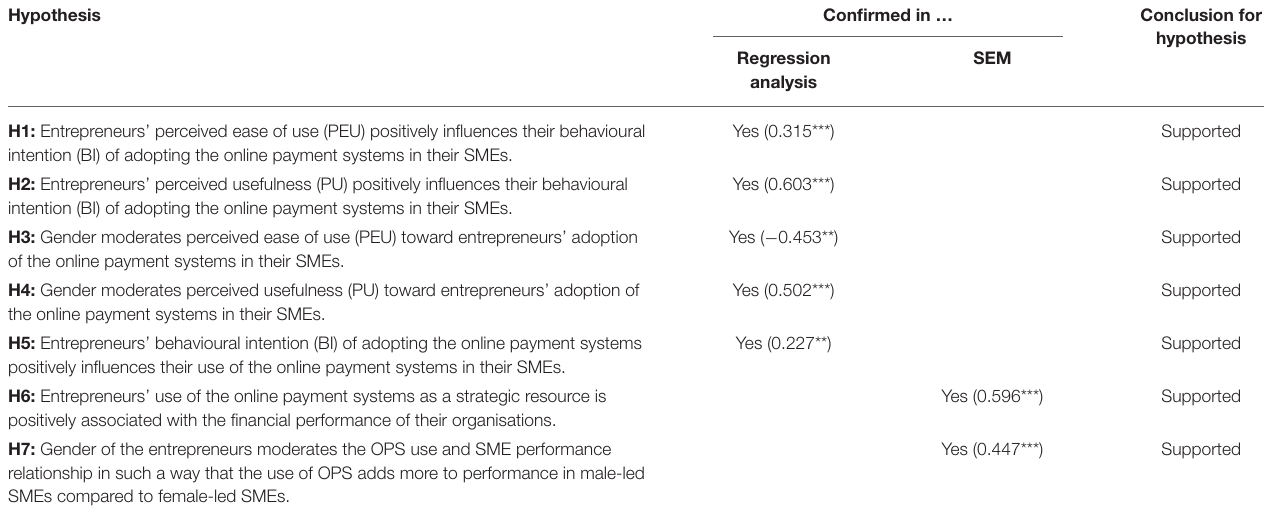
TABLE 4 | Outcomes of hypotheses test.